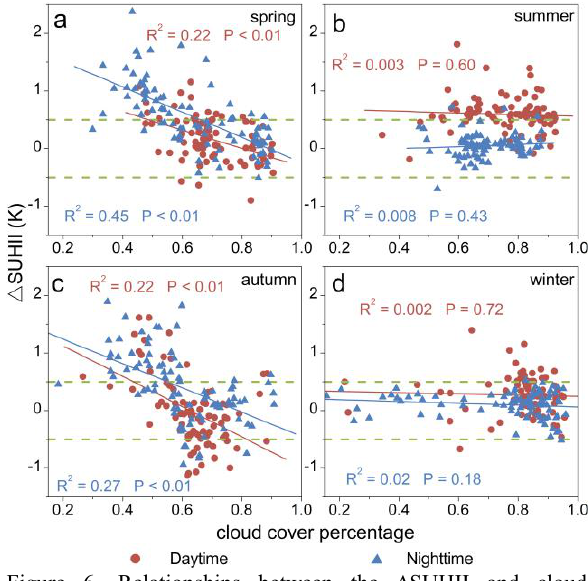
Figure 5. Spatial distributions of the annual mean ∆SUHII within the chosen seven cities during the night. Urban areas (within the black lines) and rural areas within a 15-km buffer zone are shown for each city.